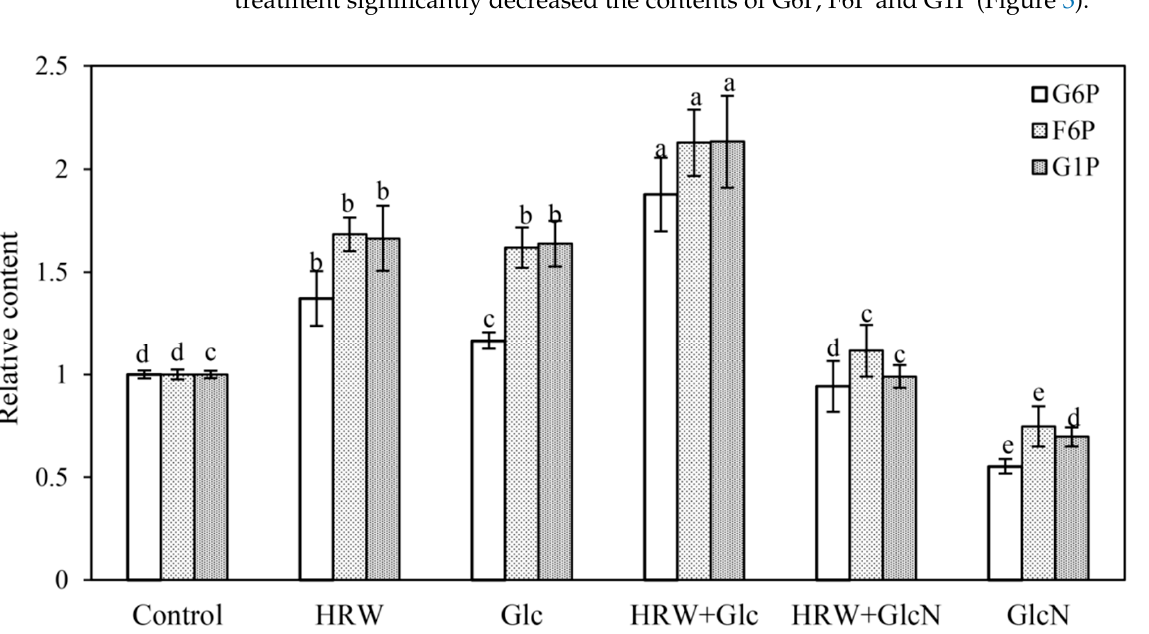
Figure 3. Changes in the contents of G6P, F6P and G1P of cucumber explants under the treatments of HRW, Glc and GlcN. n = 30 explants per replicate. Bars with different lower case letters were significantly different ( p < 0.5). HRW: hydrogen rich water; Glc: glucose; GlcN: glucosamine; G6P: glucose-6-phosphate; F6P: fructose-6-phosphate; G1P: glucose-1-phosphate. The relative content (compared to the control) is displayed in the figure.